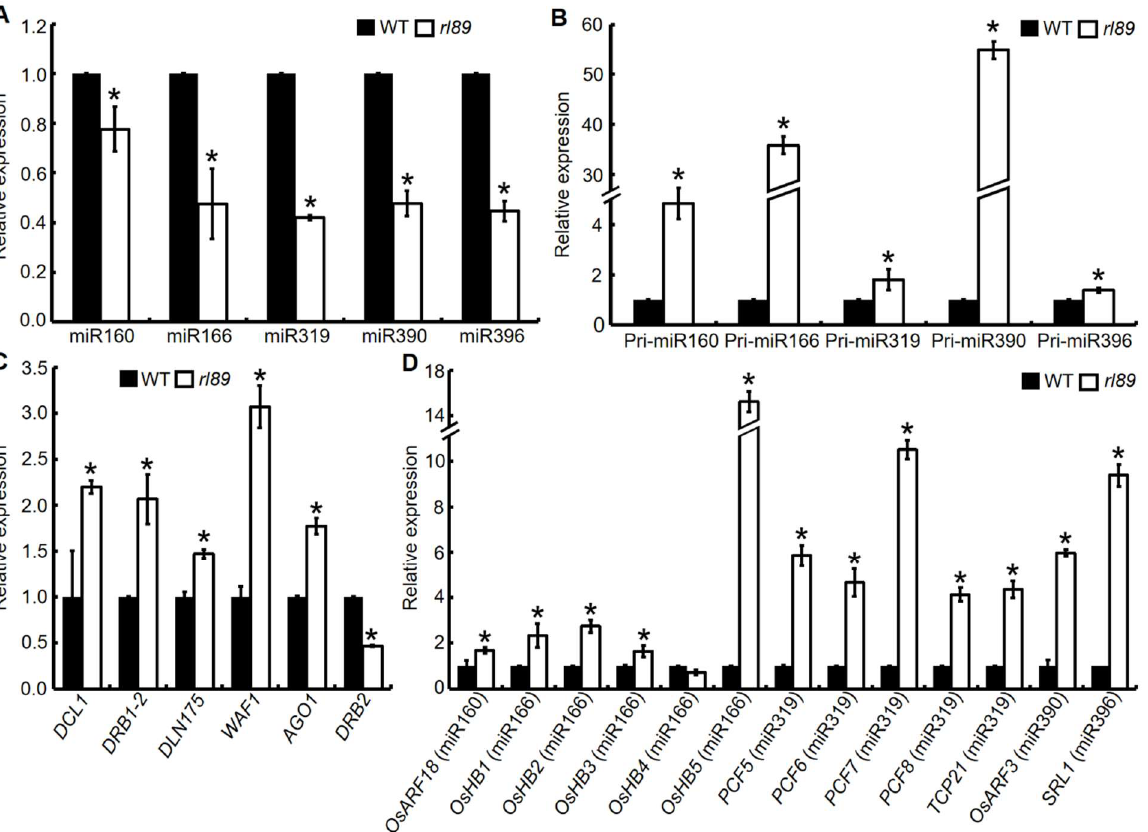
Figure 8. Expression analyses of miRNAs and their target genes related to leaf polarity and/or morphology development. ( A ) Relative expression of five miRNAs associated with leaf development. The 12th leaves (64 d after sowing, the leaf blades were just fully expanded) were harvested from the rl89 mutant and its wild type (WT) for a stem-loop primer-based quantitative reverse transcription PCR (SL-qPCR). The relative mRNA amount of each miRNA was normalized to snRNA U6. The relative expression of each miRNA in WT was normalized to 1, and those in rl89 were calculated accordingly. ( B – D ) Expression levels of the corresponding Pri-miRNAs, some genes encoding miRNA processing proteins, and some target genes of the five miRNAs, respectively. The total RNA was extracted from the 12th leaves (64 d after sowing) of rl89 and WT, respectively. The relative mRNA amount of each gene in ( B – D ) was normalized to Osubiquitin and OsActin genes, respec- tively. The relative expression of each gene in WT was normalized to 1, and those in rl89 were cal- culated accordingly. Error bars represent the SDs of three independent experiments. Asterisks indi- cate statistically significant differences compared with the wild type at p < 0.05.